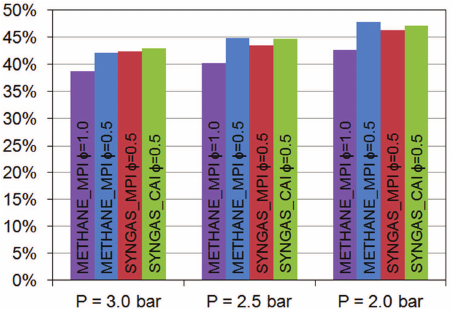
Fig. 16. Results of thermal efficiency for final operating points